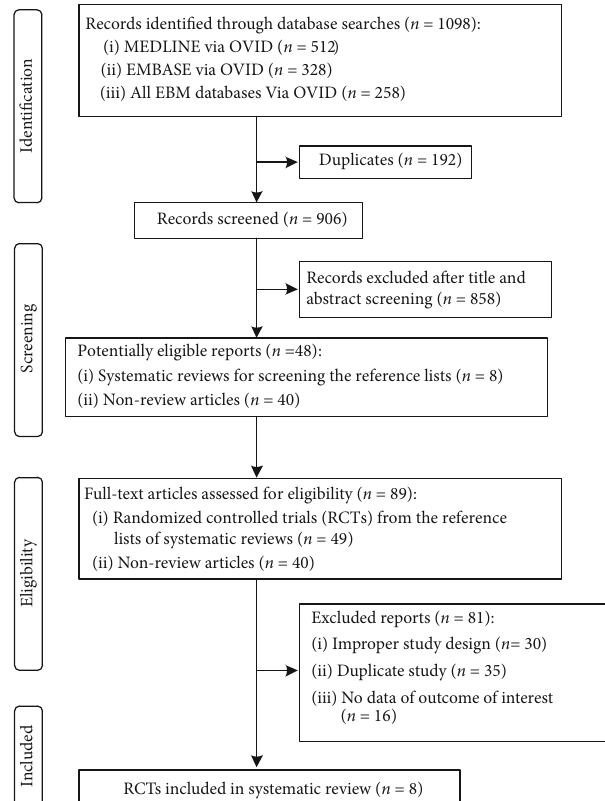
Figure 1: Flow chart for identifying eligible